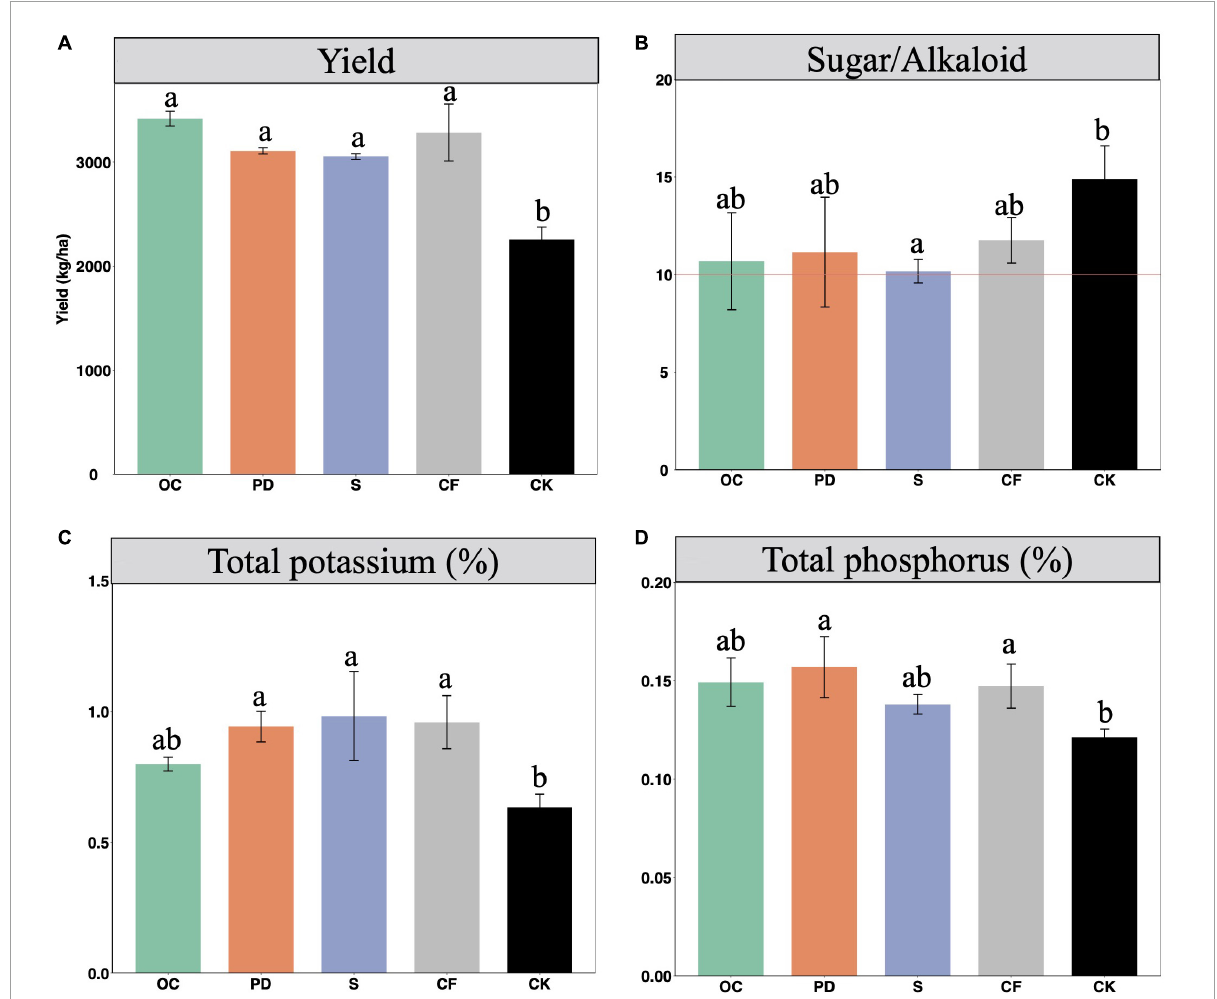
FIGURE1 The yields (A) and qualities, including ratio of sugar to alkaloids (B) , total potassium (C) , and total phosphorus (D) of tobacco under different fertilization management after 12-year tobacco-maize rotation, where the combined addition of fertilization includes oil cake and inorganic nitrogen (OC), pig dung and inorganic nitrogen (PD), straw and inorganic nitrogen (S), inorganic nitrogen (CF), and no fertilization (CK). The yield is the dry matter weight of leaves after first flue-cured. Tobacco with the ratio value of sugar over alkaloid 10 is considered as the most proper. Data are means ± SE. Significant differences were determined by ANOVA, Fisher’s least significant difference (LSD) test ( P < 0.05) and indicated by different